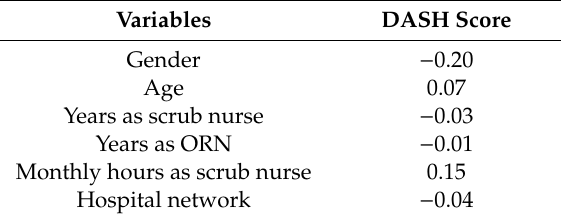
Table 2. Correlation between selected socio-demographic factors, job characteristics and disabilities of the arm, shoulder and hand (DASH) score of 148 operating room nurses (ORNs). Italy, 2018. Variables DASH Score Gender − 0.20 Age 0.07 Years as scrub nurse − 0.03 Years as ORN − 0.01 0.15